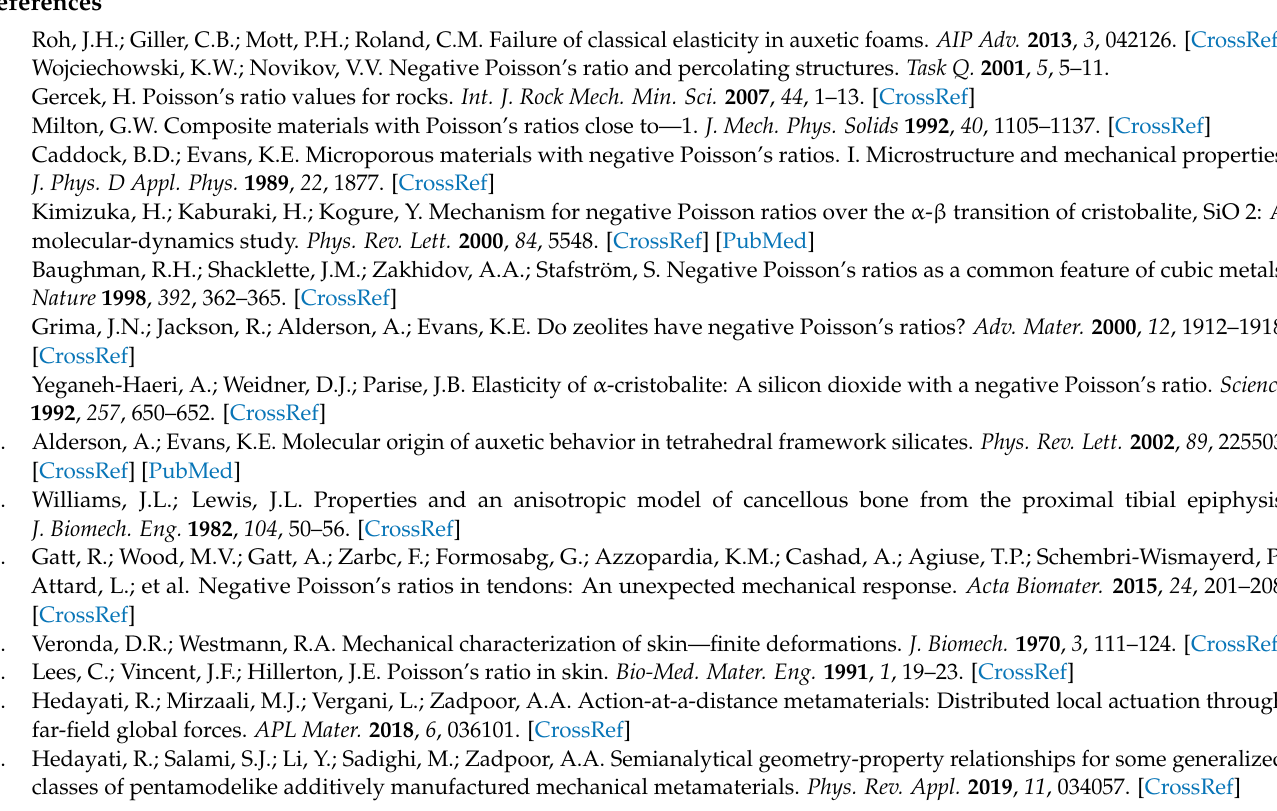
stress, Figure S12: Variation of mechanical properties for general and lightened unit cell with respect to µ and θ parameters: (a) normalized elastic modulus, (b) Poisson’s ratio, and c) normalized yield stress, Figure S13: Mechanical properties curves of general and lightened 3D re-entrant structures with ϕ = 22.5, θ = 22.5: (a) Poisson’s ratio, (b) elastic modulus, and (c) yield stress, Figure S14: Contour plots of mechanical properties for general (left) and lightened (right) unit cell with respect to µ and θ parameters: (a,b) normalized elastic modulus, (c,d) Poisson’s ratio, and (e,f) normalized yield stress, Figure S15: Von Mises equivalent stress (Beam 189 elements), Figure S16: Von Mises equivalent strain (Beam 189 elements), Figure S17: 1st principal stress (Beam 189 elements), Figure S18: 2nd principal stress (Beam 189 elements), Figure S19: 3rd principal stress (Beam 189 elements), Figure S20: 1st principal strain (Beam 189 elements), Figure S21: 2nd principal strain (Beam 189 elements), Figure S22: 3rd principal strain (Beam 189 elements), Figure S23: Normal stress distribution in the beam elements of models made of BEAM 189 element types, Figure S24: Bending stress distribution in the beam elements of models made of BEAM 189 element types, Figure S25: Von Mises equivalent stress for FE models based on solid elements, Figure S26: Von Mises equivalent strain for FE models based on solid elements. Figure S27: Von Mises equivalent stress for FE models based on solid elements. The unit cells are cut from the central plane for better